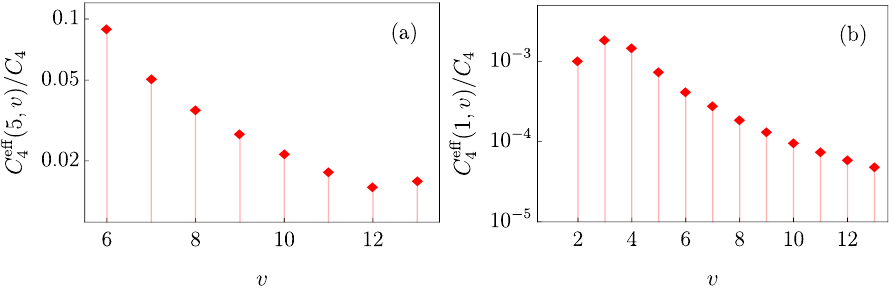
Figure 3. ( a ) Effective coupling coefficients C eff between the 5th vibrational state and the ones right 4 below it in units of the diagonal coupling constant. ( b ) Same, but for the most weakly bound